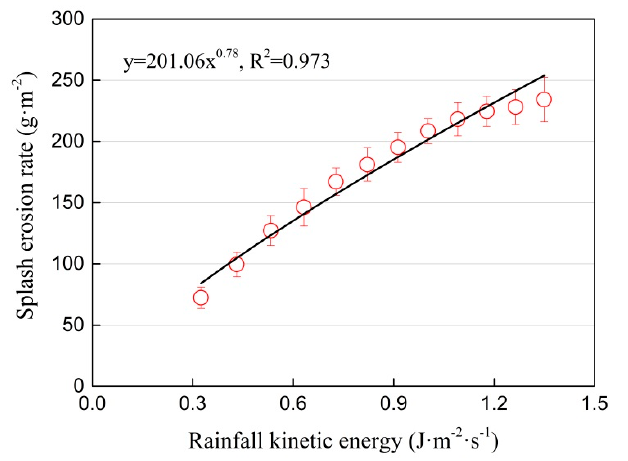
Figure 5. Relationship between splash erosion rate and rainfall kinetic energy on bare land.